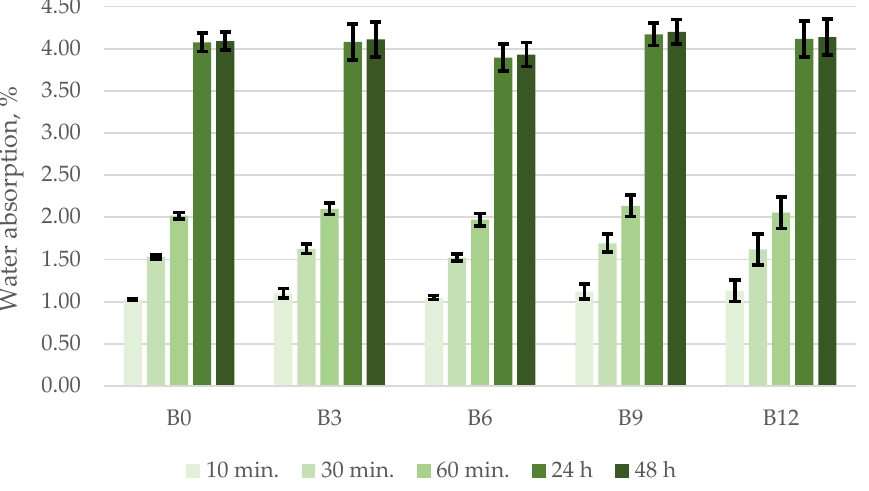
Figure 5. Water absorption kinetics of the concrete specimens.